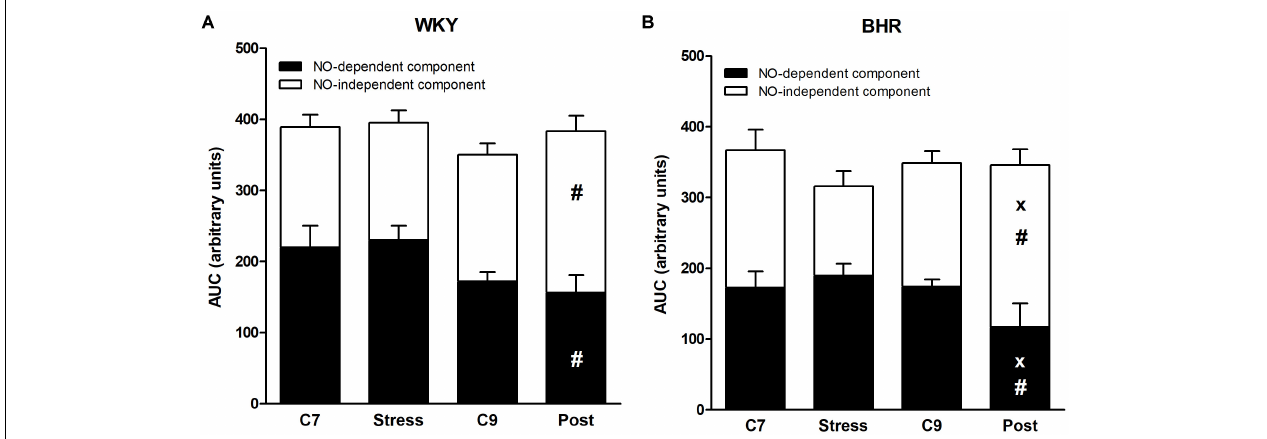
FIGURE 5 | Acetylcholine-induced relaxation of the femoral artery of normotensive Wistar-Kyoto (WKY, A ) and borderline hypertensive (BHR, B ) rats. AUC, area under the curve; C7, seven-week controls; C9, nine-week controls; NO, nitric oxide; Post, post-stress. The results are mean ± SEM, n = 6–10/group. Symbols: # p < 0.05 vs. stress of the same phenotype, x p < 0.05 vs. nine-week controls (C9) of the same